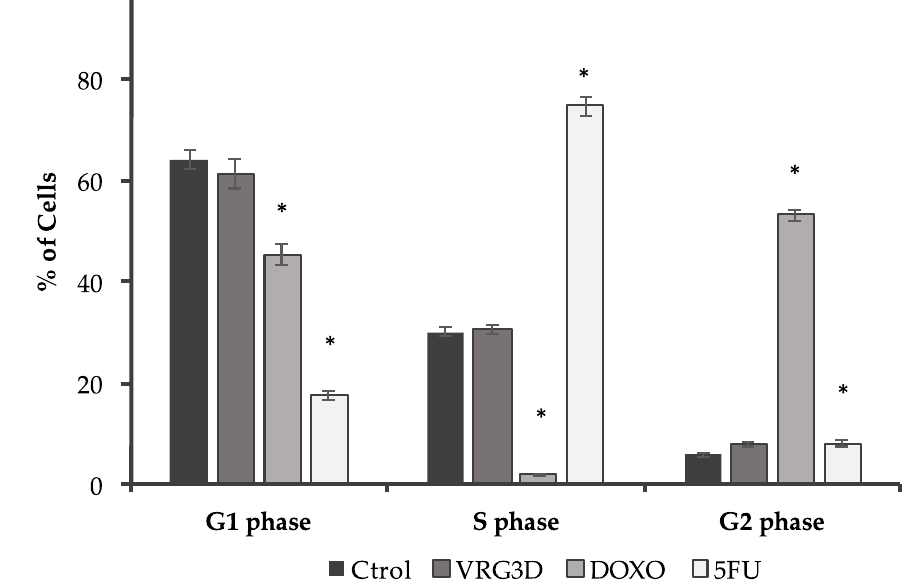
Figure 6. Modulation of cell cycle analysis by 3d-germinated mung bean extract in T-84 cell line. FACS scan analysis results were expressed as the percentage of labelled cells in each cell cycle phase. Results are represented as means ± SEM. CTROL, no treatment; DOXO, Doxorrubicin; 5FU, 5 Fluorouracil; VRG3D, 3d-germinated Vigna radiata . * indicates a significance of p < 0.05 between the treatment and control.